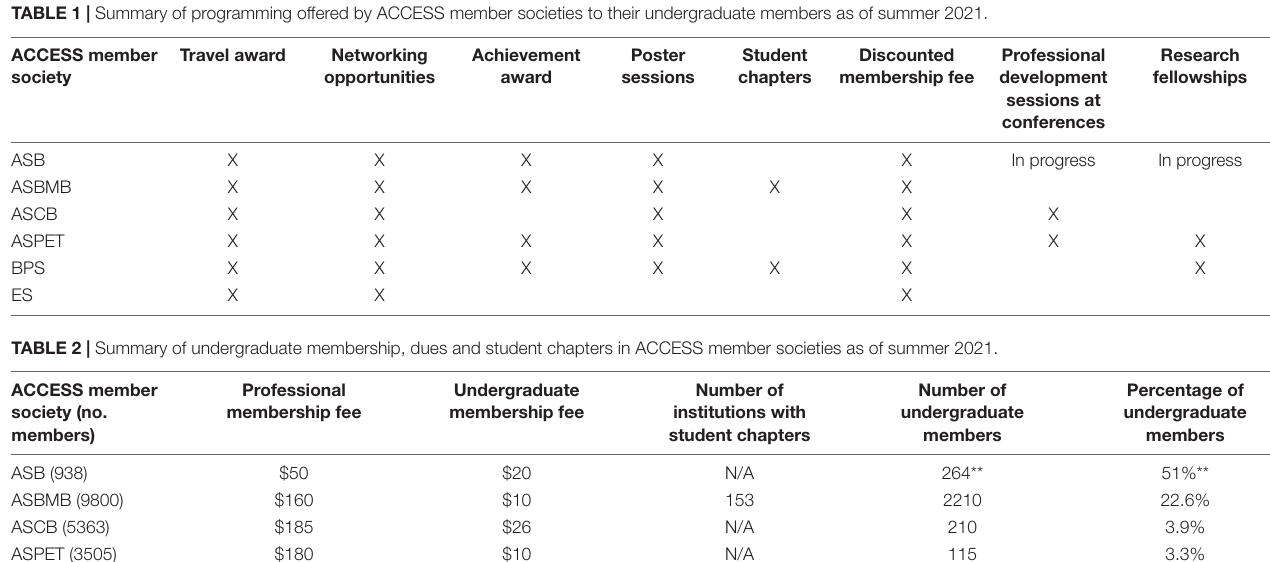
TABLE 1 | Summary of programming offered by ACCESS member societies to their undergraduate members as of summer 2021.